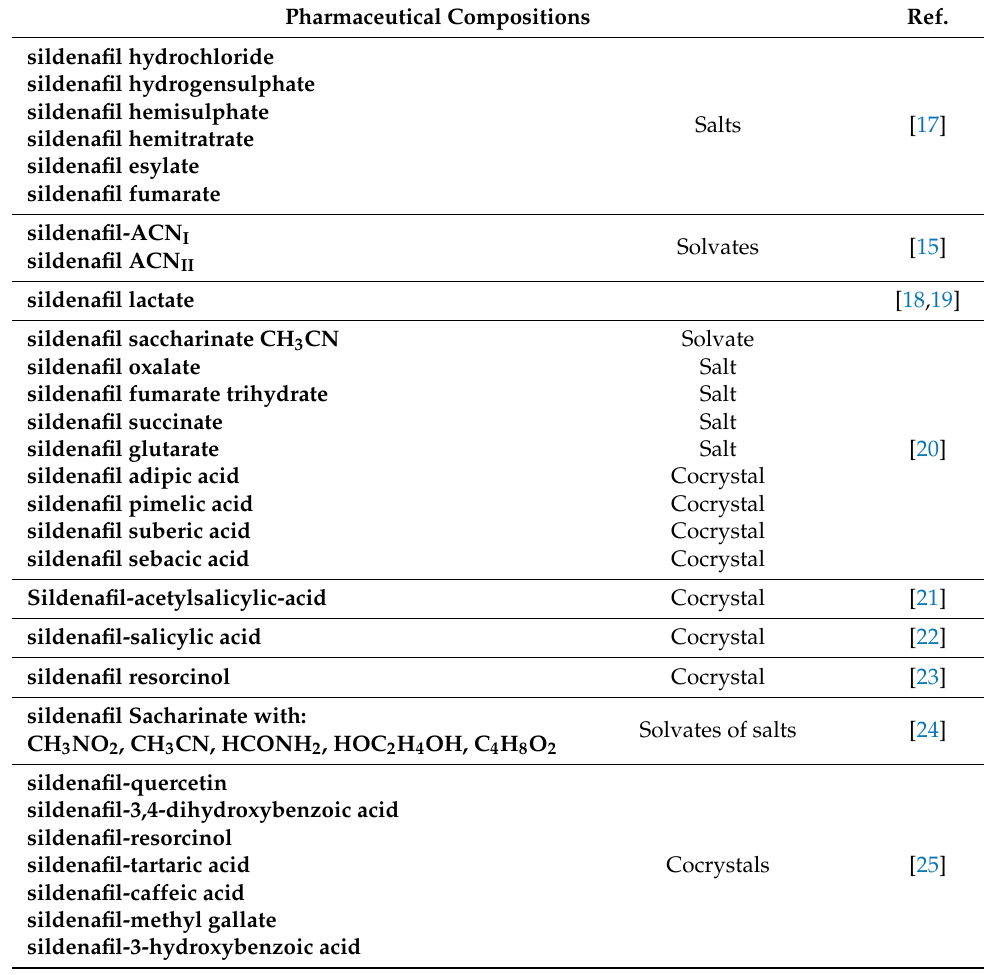
Table 1. Indicative references to salts, cocrystals and solvates of sildenafil. Pharmaceutical